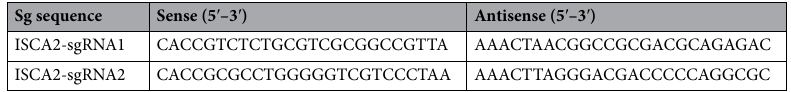
Table 1. The target sequences for sgRNA against the human ISCA2